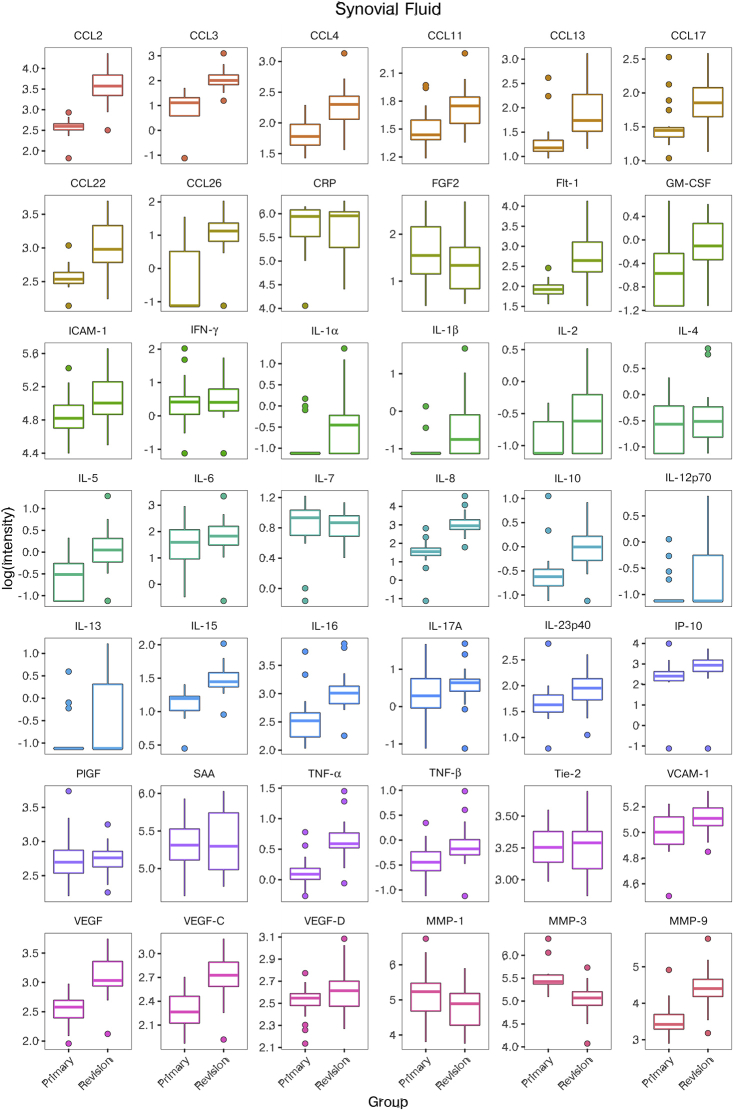
Protein expression profile of synovial fluid isolated from patients undergoing primary and revision total knee arthroplasty. Data are presented as box-and-whiskers plot. CRP, C-reactive protein; FGF, fibroblast growth factor; Flt, Fms-like tyrosine kinase 1; GM-CSF, granulocyte-macrophage colony-stimulating factor; ICAM, intercellular adhesion molecule; IFN, interferon; IP-10, interferon gamma-induced protein 10; MMP, matrix metalloproteinase; PIGF, placental growth factor; SAA, serum amyloid A; Tie, tyrosine kinase; TNF, tumor necrosis factor; VCAM, vascular cell adhesion molecule; VEGF, vascular endothelial growth factor.